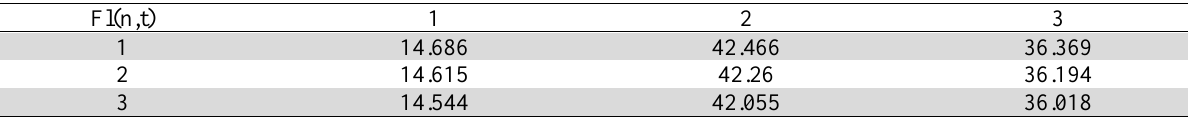
The results of Fl(n,t)